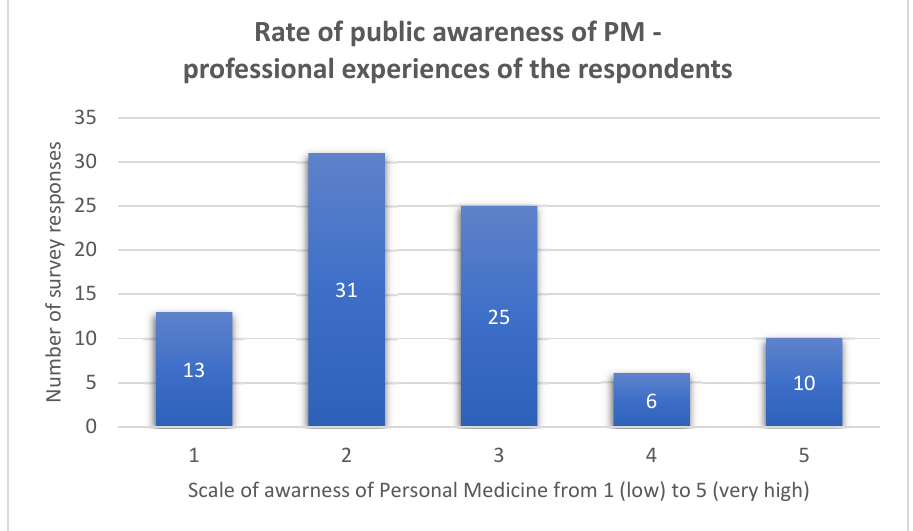
Figure 1. Rate of public awareness of PM—professional experiences of the respondents (survey data).